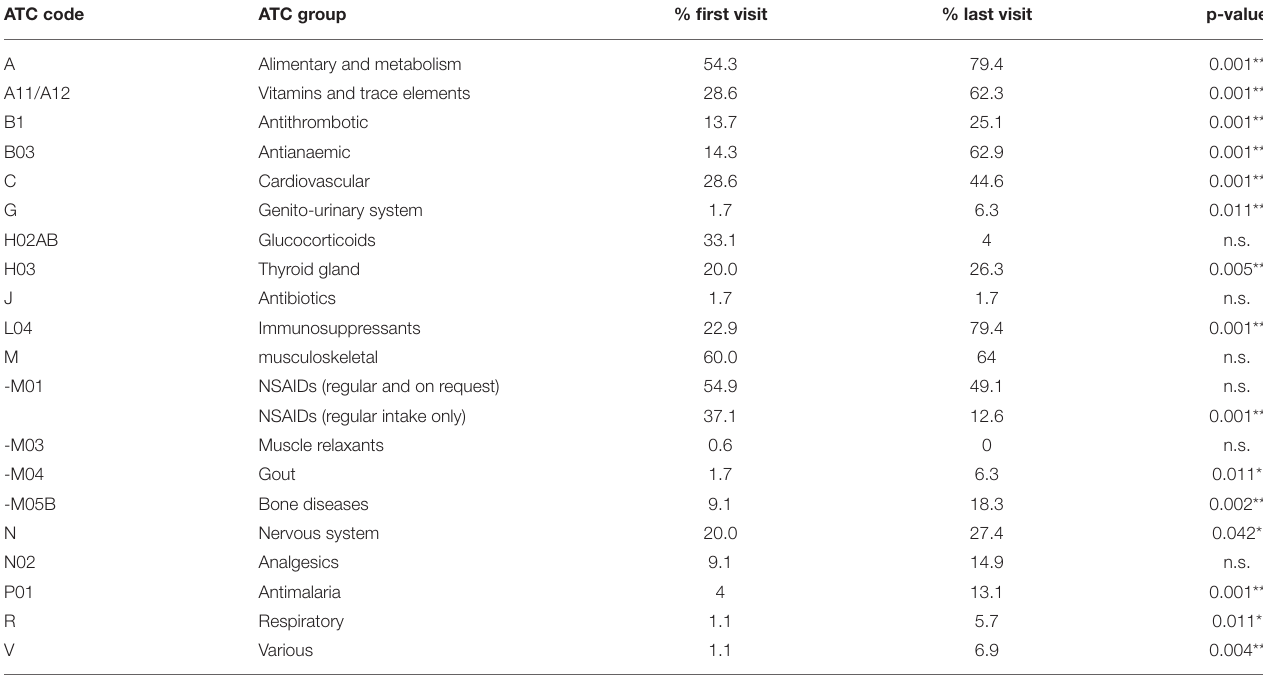
TABLE 5 | Percentages of ATC-coded medication groups at first and last visit (in alphabetical order). ATC